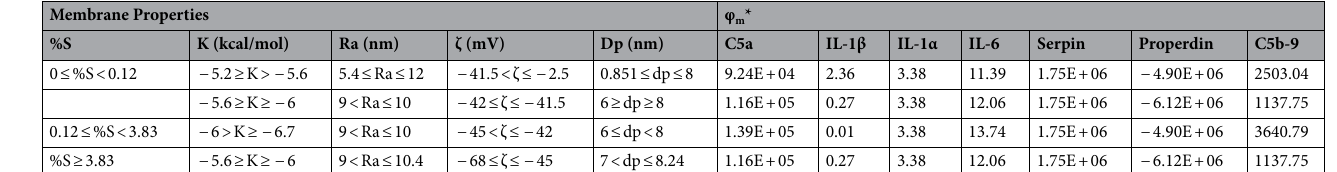
Table 2. Material correction factors ( ϕ M ) for various clinical membrane materials. *These correction factors can be added to any of the respective biomarker equations while setting Qb = 0 and t = 30 min. For C5a, the factors can be added to Eqs. (1, 9, 17, 25, and 33); for IL-1β, the factors can be added to Eqs. (5, 13, 21, 29, and 37); for IL-1α, the factors can be added to Eqs. (6, 14, 22, 30, and 36); for IL-6, the factors can be added to Eqs. (7, 15, 23, 31, and 39); for serpin, the factors can be added to Eqs. (4, 12, 20, 28, and 36); for properdin, the factors can be added to Eqs. (2, 10, 18, 26, and 34); and for C5b-9, the factors can be added to Eqs. (3, 11, 19, 27, and